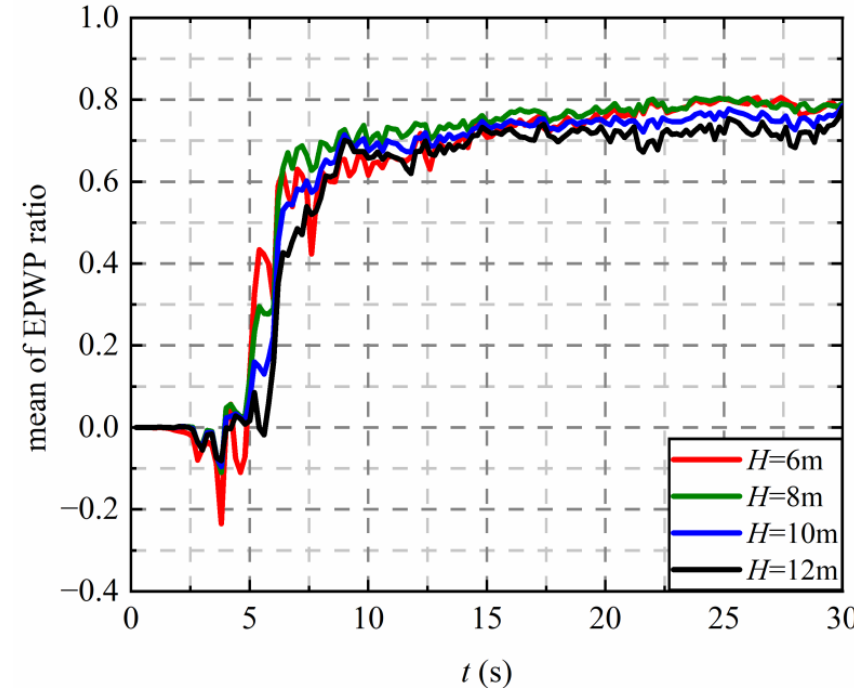
Figure 6. Influence of the tunnel embedment depths on the EPWP ratio at Point A.